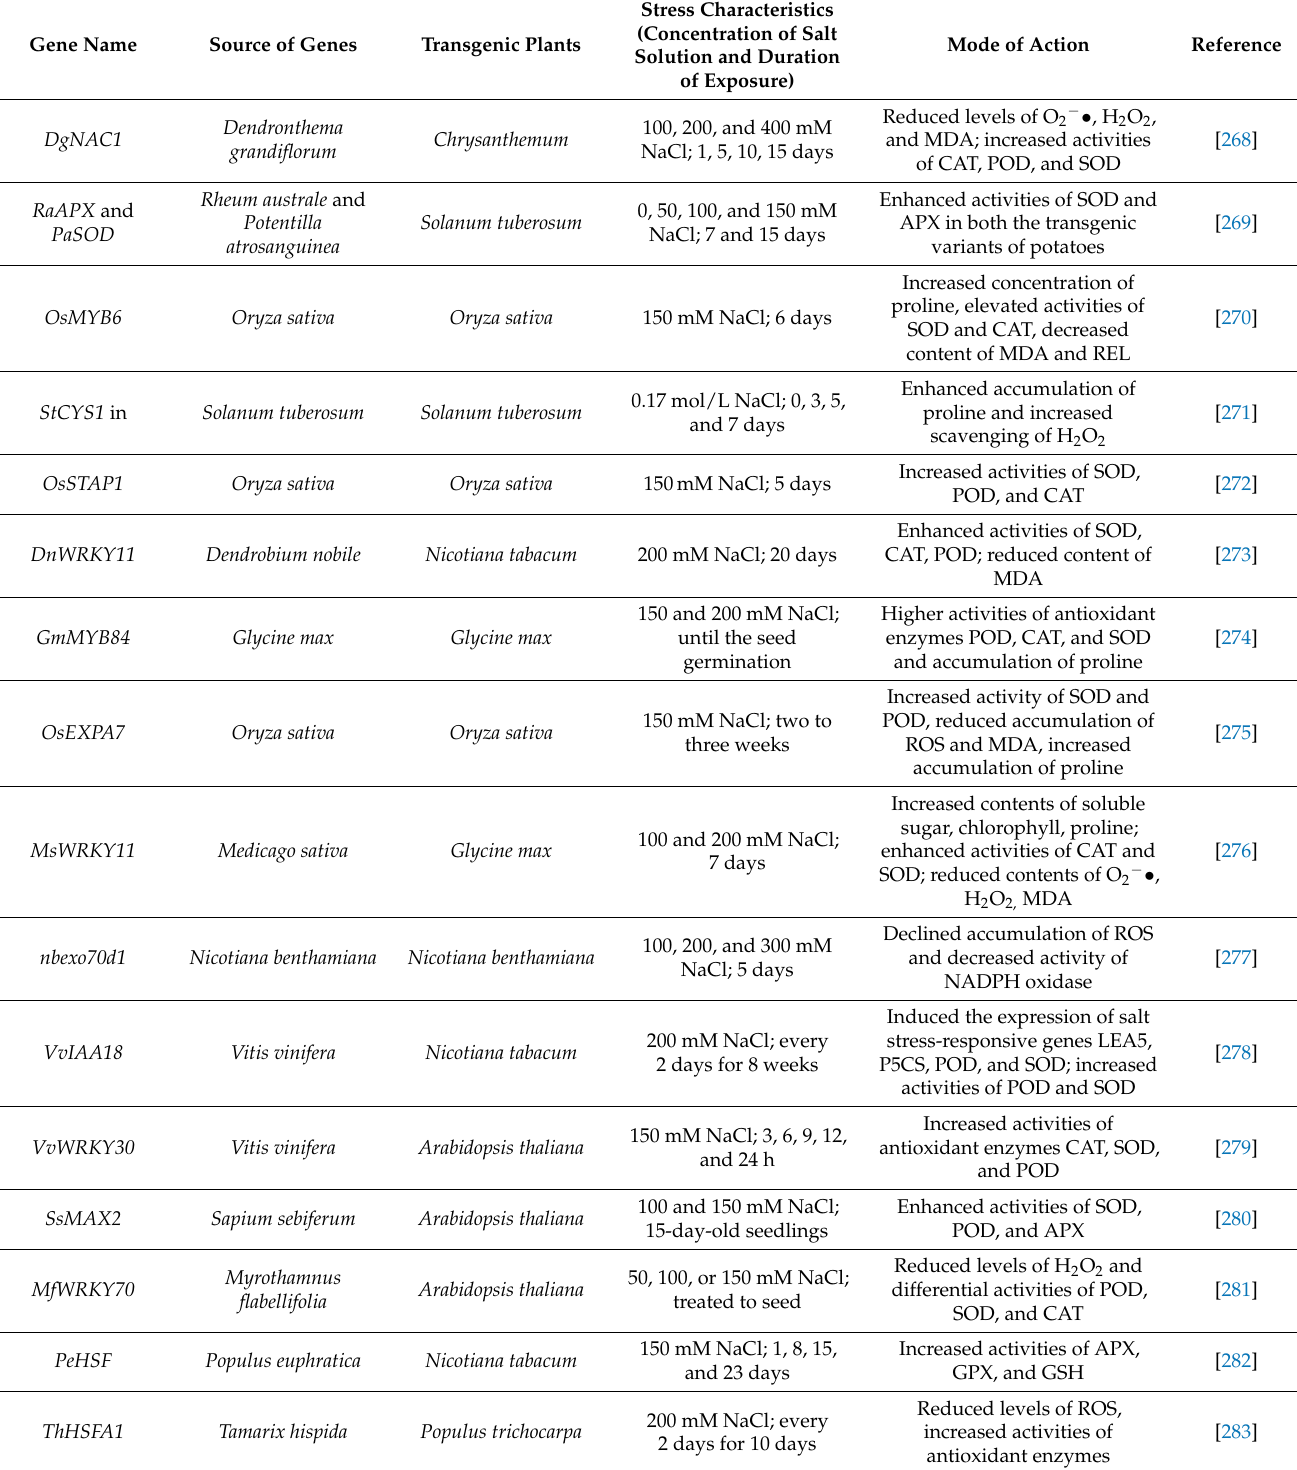
Table 2. Genetic engineering methods—recent advances to improve the antioxidant defense machin- ery under salt